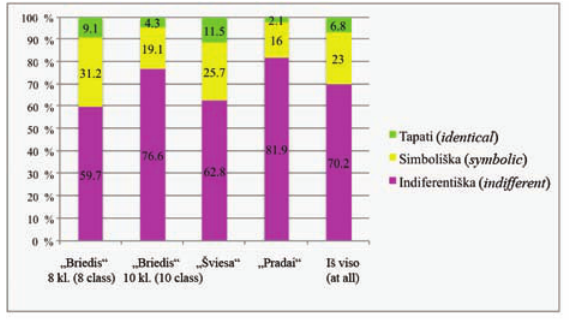
Fig. 3 . Sign association with colour in the analysed economic maps of scholastic geographical atlases